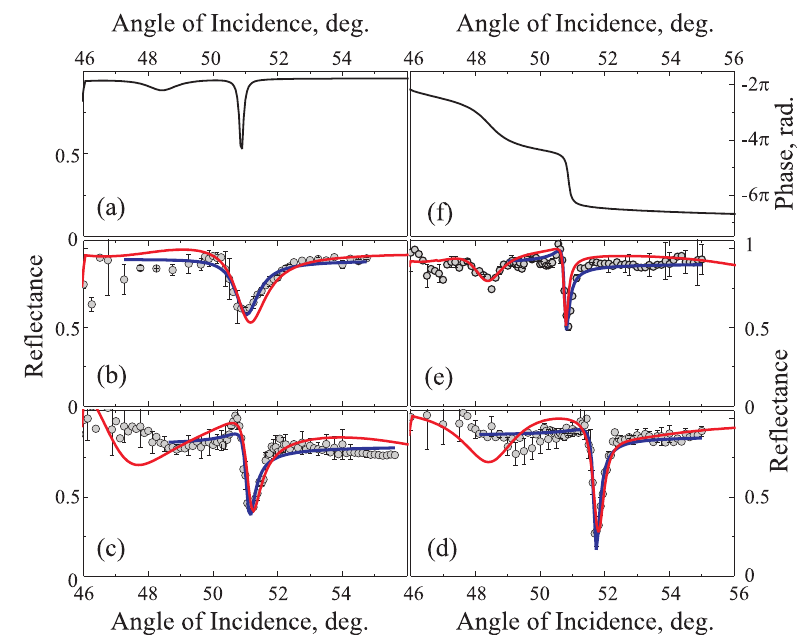
Figure 3. ( a ) The model angular reflectance spectrum of the one-dimensional photonic crystal below the light line; ( b – e ) Experimental angular reflectance spectra (circles) of samples with 9, 11, 13 or 15 bilayers, and their fits according to numerical models (curves). Incident light is s -polarized. Dips in the spectra correspond to BSW excitation; ( f ) The model angular spectrum of the phase of the complex reflection coefficient. Reprinted with permission from I.V. Soboleva, V.V. Moskalenko, A.A. Fedyanin, Phys. Rev. Lett. 108, 123901 (2012). Copyright (2012) by the American Physical Society